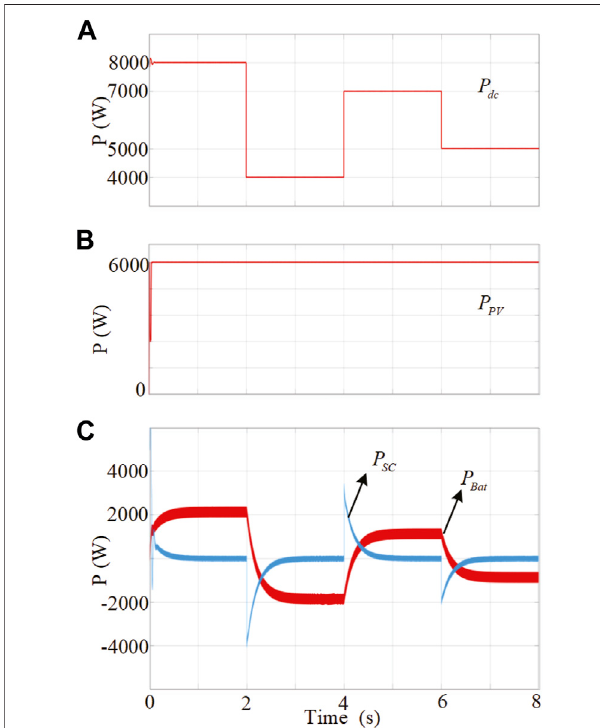
FIGURE 19 | (A) DC bus output power P dc ; (B) PV array output power P PV ; (C) HESS output power.